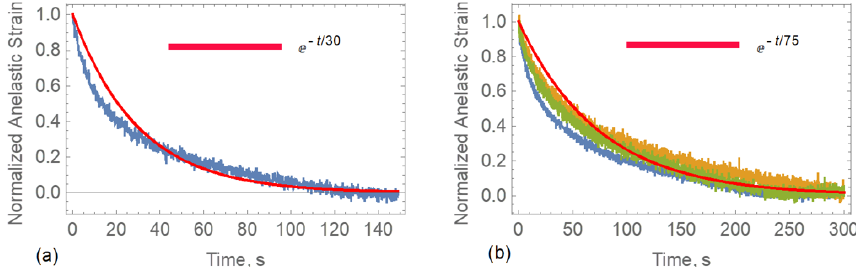
Figure B6. Normalized strain versus time in LU tests performed with (a) spray and (b) columnar sea ice cores (ice temperature is 5 ◦ C).